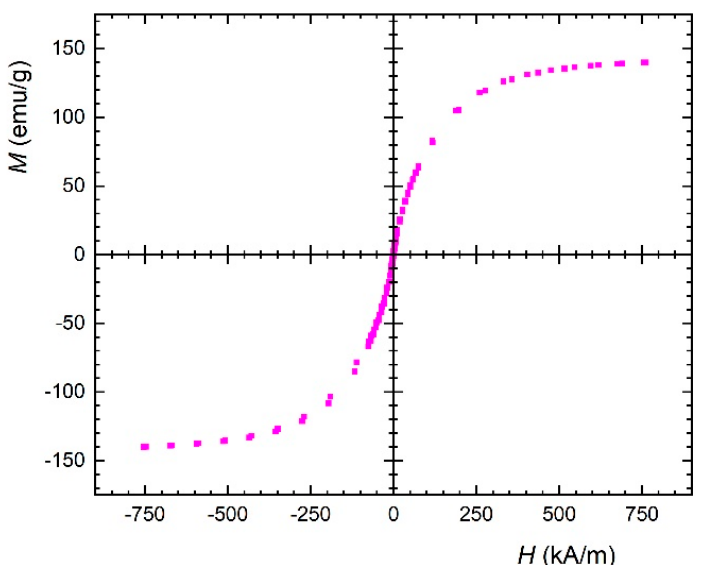
Figure 4. Magnetisation curve of the MR slurry.